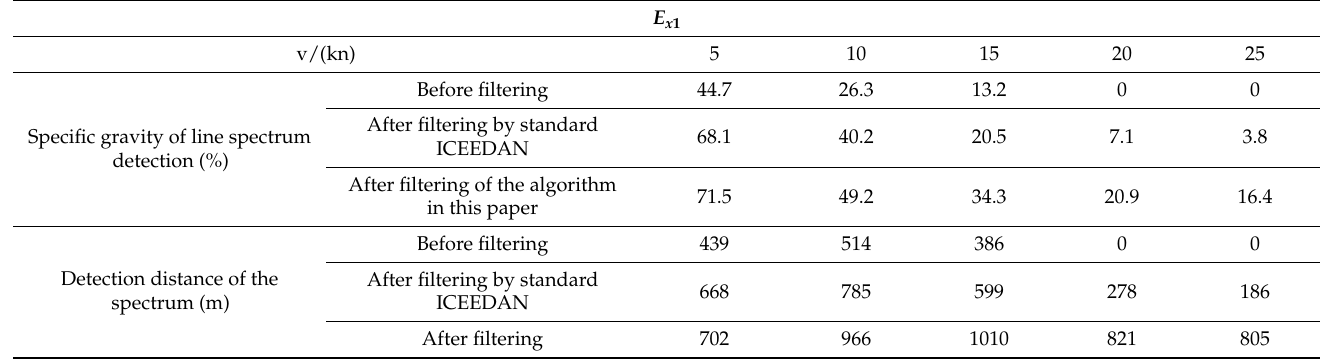
Figure 11. Temporal distribution comparison of bow longitudinal component E x 1 before and after filtering at different speeds. ( a ) Temporal distribution at 5 kn before filtering; ( b ) Temporal distribution at 5 kn after filtering; ( c ) Temporal distribution at 10 kn before filtering; ( d ) Temporal distribution at 10 kn after filtering; ( e ) Temporal distribution at 15 kn before filtering; ( f ) Temporal distribution at 15 kn after filtering; ( g ) Temporal distribution at 20 kn before filtering; ( h ) Temporal distribution at 20 kn after filtering; ( i ) Temporal distribution at 25 kn before filtering; ( j ) Temporal distribution at 25 kn after filtering. Table 5. Comparison of line spectrum detection results before and after filtering.